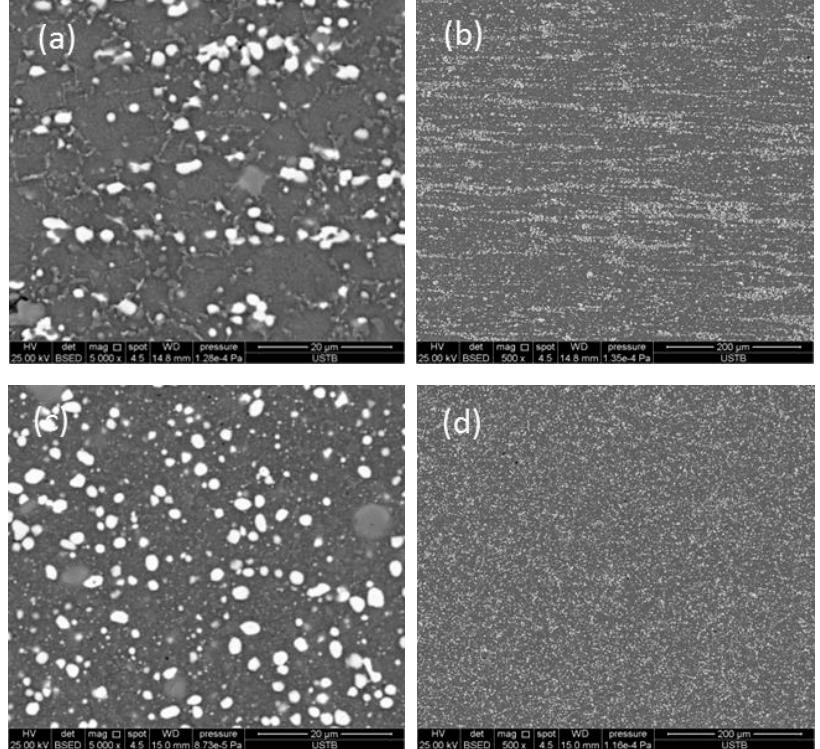
Figure 9. The microstructure of HSS after forging ( a , b ) and hot rolling ( c , d )